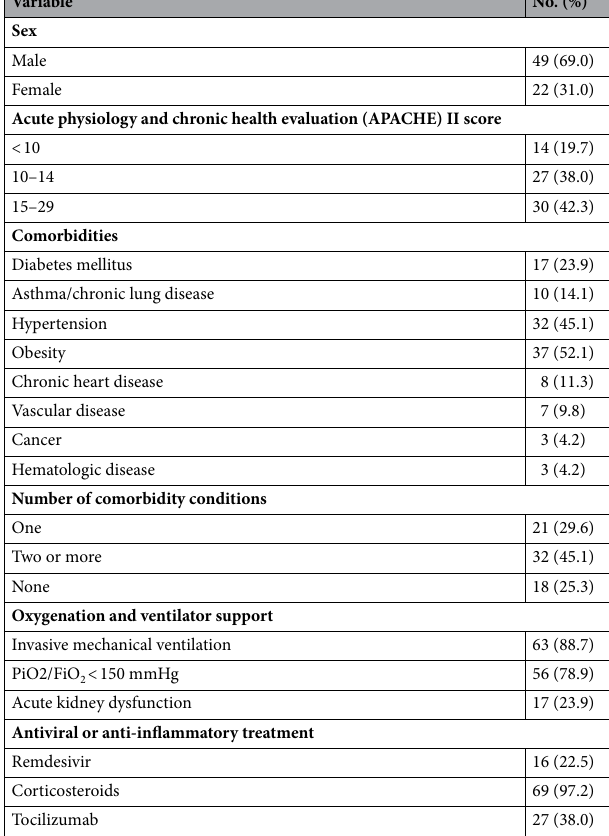
Table 1. Baseline clinical characteristics of the study population at Intensive Care Unit